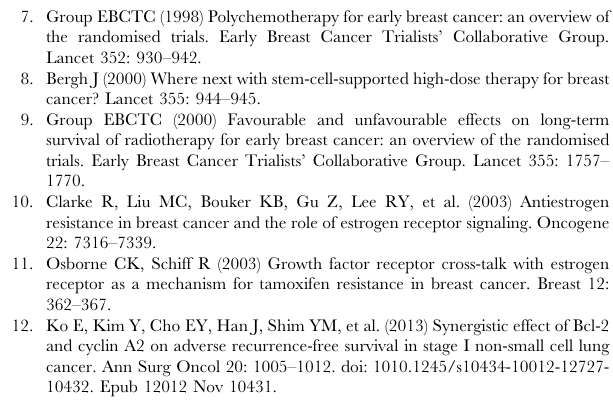
Figure S1 Kaplan-Meier plot for DMFS ( A ), DFS ( B and C ), RFS( D ) of ER + breast cancer patients classified according to the tertile of CCNA2 expression levels. ( E and F ) Kaplan-Meier plot for OS of breast cancer pateints classified according to the tertile of CCNA2 expression level. Significance was assessed by logrank test. Figure S2 ( A and B ) Kaplan-Meier plot for DMFS of tamoxifen treated breast cancer patients classified according to the tertile analysis of CCNA2 expression level, significance was assessed by logrank test. Gene set enrichment analysis of CCNA2 mRNA expression in relation to gene set up-regulated in endocrine resistant patients (C) and gene set down-regulated in tamoxifen resistant MCF-7 cells (D) using breast cancer expression profiles